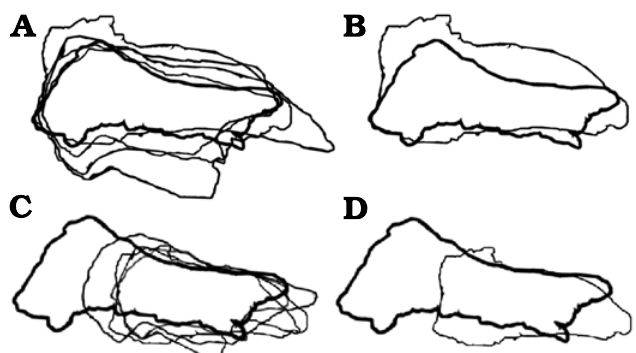
Fig. 7. Björk method of superimposition of the frontals in lateral/medial views. A . Scaled to same length between prefrontonasal process and the frontoparietal suture. B . Smallest and largest specimen superimposed. C . Scaled to same depth near the lacrimal socket region. D . Smallest and largest specimen superimposed. Largest specimens preserve entire nasal process, which emphasize relative shortening during growth. Not to